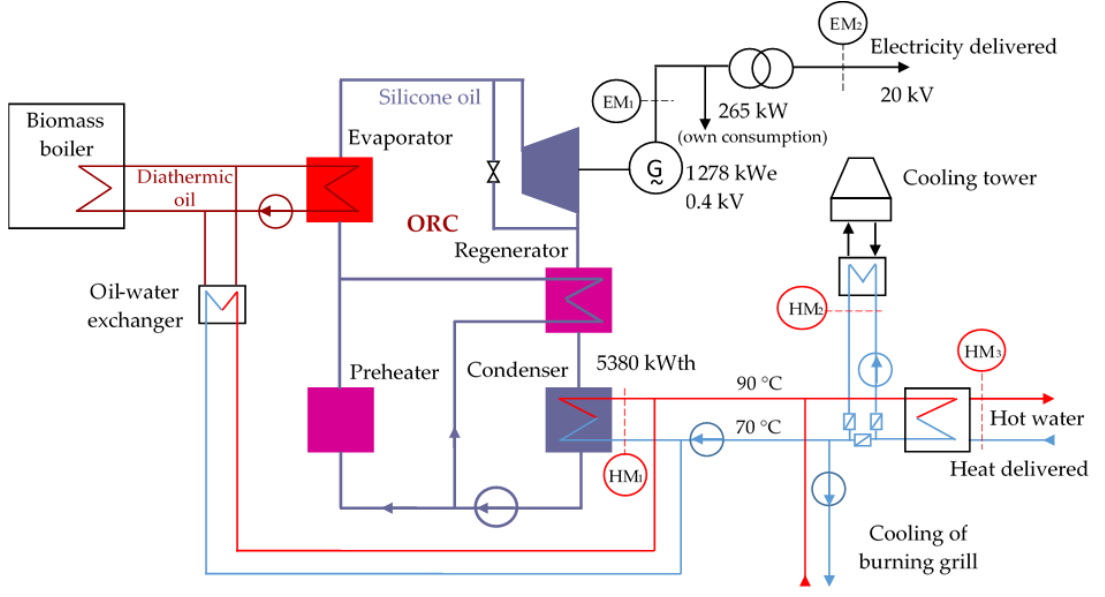
Figure 5. The schematic diagram of the CHP plant with the Organic Rankine Cycle (ORC) technology and biomass fuel.